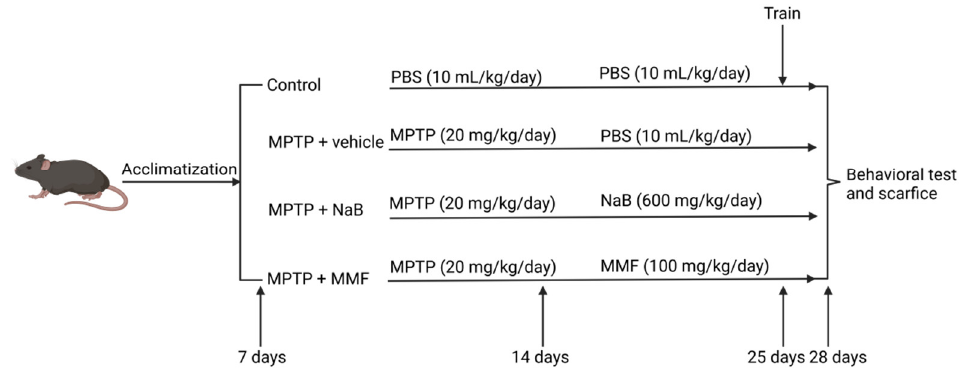
Figure 2. The treatment flow chart for